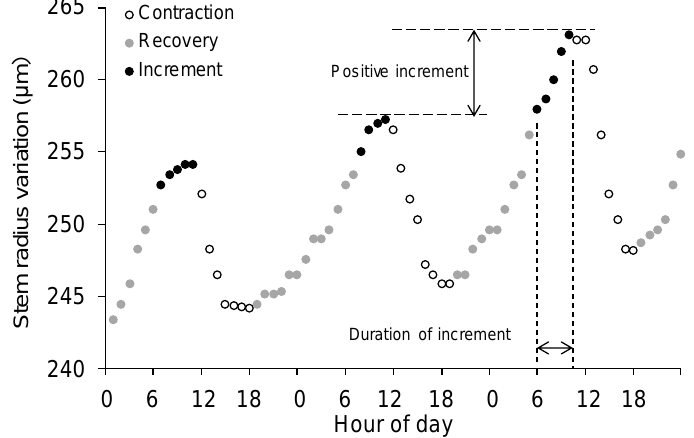
Figure 2. Schematic figure of the diurnal cycle of stem radius variation recorded by automatic dendrometer in Taiwan pine. The diurnal cycles are divided into three distinct phases: contraction, recovery and increment. The magnitude and duration of stem increment are indicated. Each circle represents an hourly measurement recorded in August 2017.